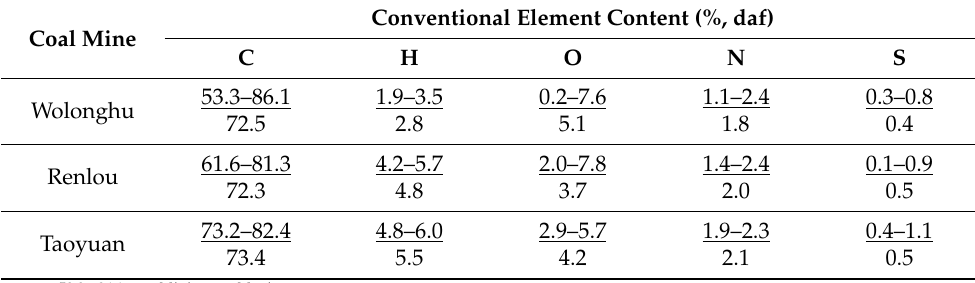
Table 2. Element contents of the selected coal samples from the Huaibei Coalfield. Coal